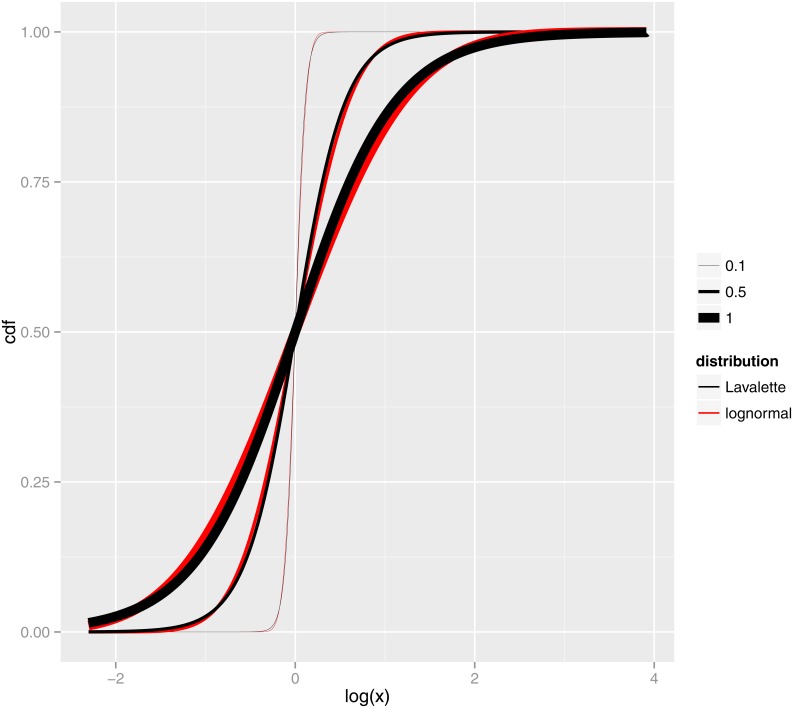
Lognormal vs Lavalette cdf.Cumulative distribution function for lognormal and Lavalette distributions, being μ = 0 and σ = 0.1, 0.5 and 1 the parameters of the lognormal. The x axis is in logarithmic scale. We see that over an important interval of the domain, it may be difficult to distinguish a lognormal from a Lavalette distribution.